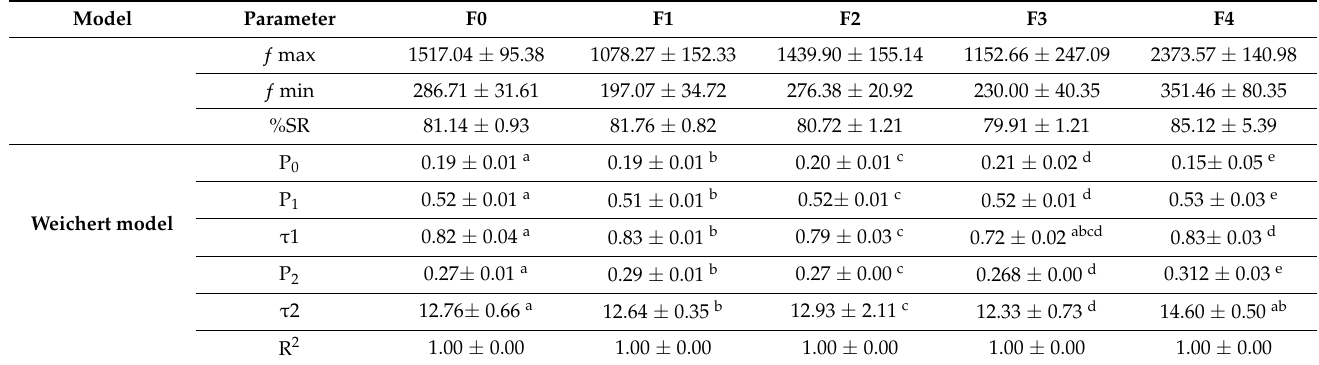
Table 3. Mechanical